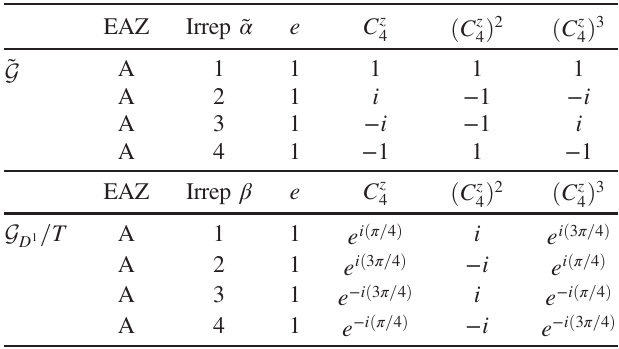
TABLE VI. Irreducible representations of the on-site symmetry ˜ G =T for P 4 group and G D 1